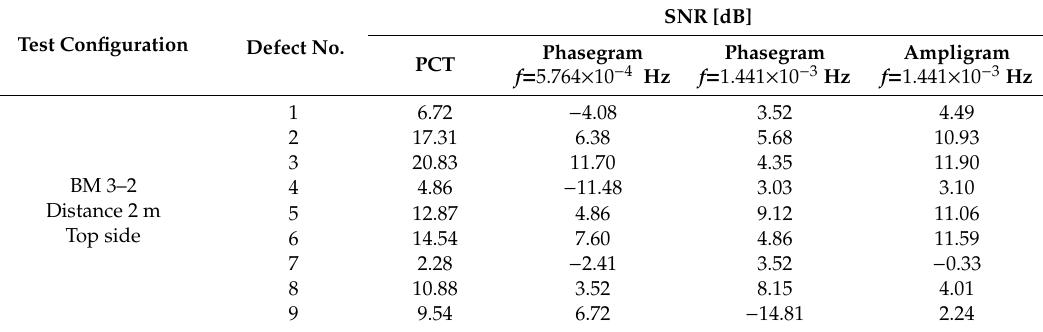
Figure 11. Comparison of results gained using two post-processing methods, BM 3–2, distance 2 m, top side: ( a ) PCT; ( b ) Phasegram ( f = 5.764 × 10 − 4 Hz); ( c ) Phasegram ( f = 1.441 × 10 − 3 Hz ) ; ( d ) Ampligram ( f = 1.441 × 10 − 3 Hz ) . Table 6. SNR values obtained from images presented in Figure 11.